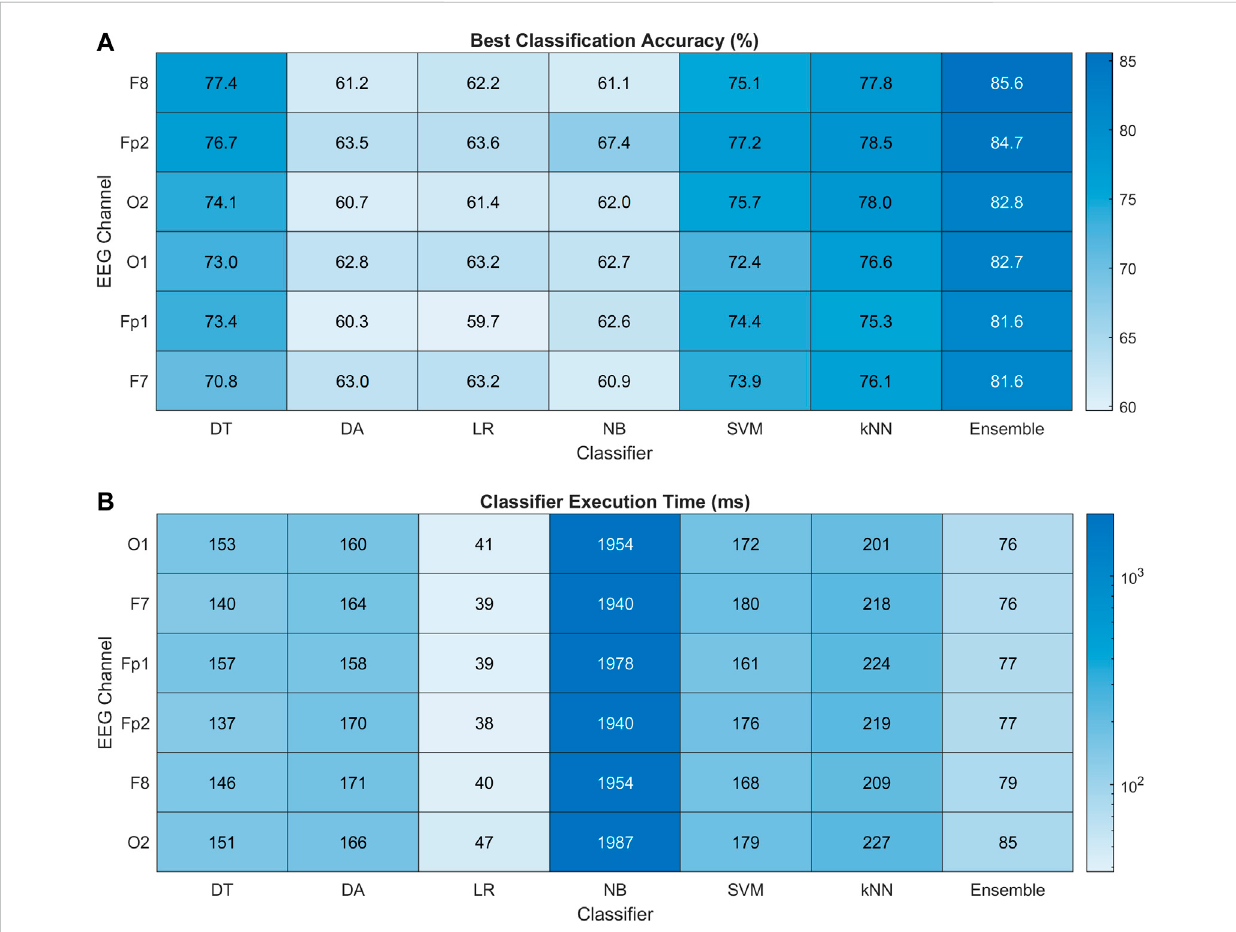
FIGURE 10 (A) Heat map chart for performance comparison with percentage accuracy of all the classi fi cation methods using δ , θ , α , β band powers only and channelrankingforthebestclassi fi er. (B) Classi fi cationcomputationtime(ms)foralltheclassi fi ersmentioningtheircomputationalcomplexityfordriving drowsiness